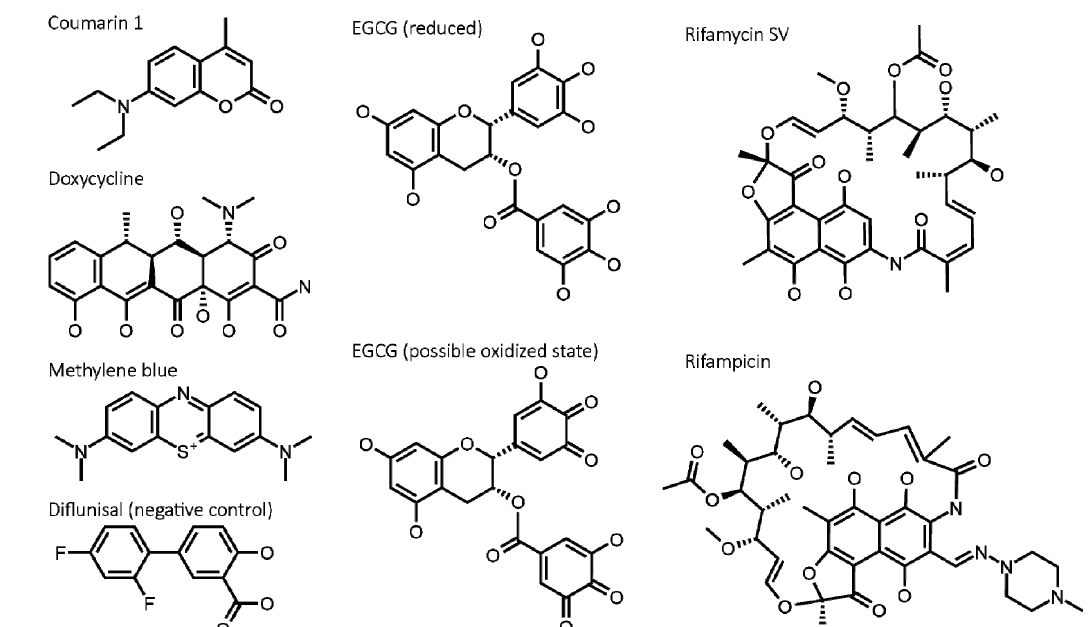
Figure 3. Structures of small molecules used in this study. The natural product EGCG can undergo oxidation to form reactive orthoquinone species such as that shown. To generate these species, EGCG solutions were incubated for 24 h at 37 °C in water. Diflunisal, a stabilizer of transthyretin, is not expected to interact with LCs and is included as a negative control.